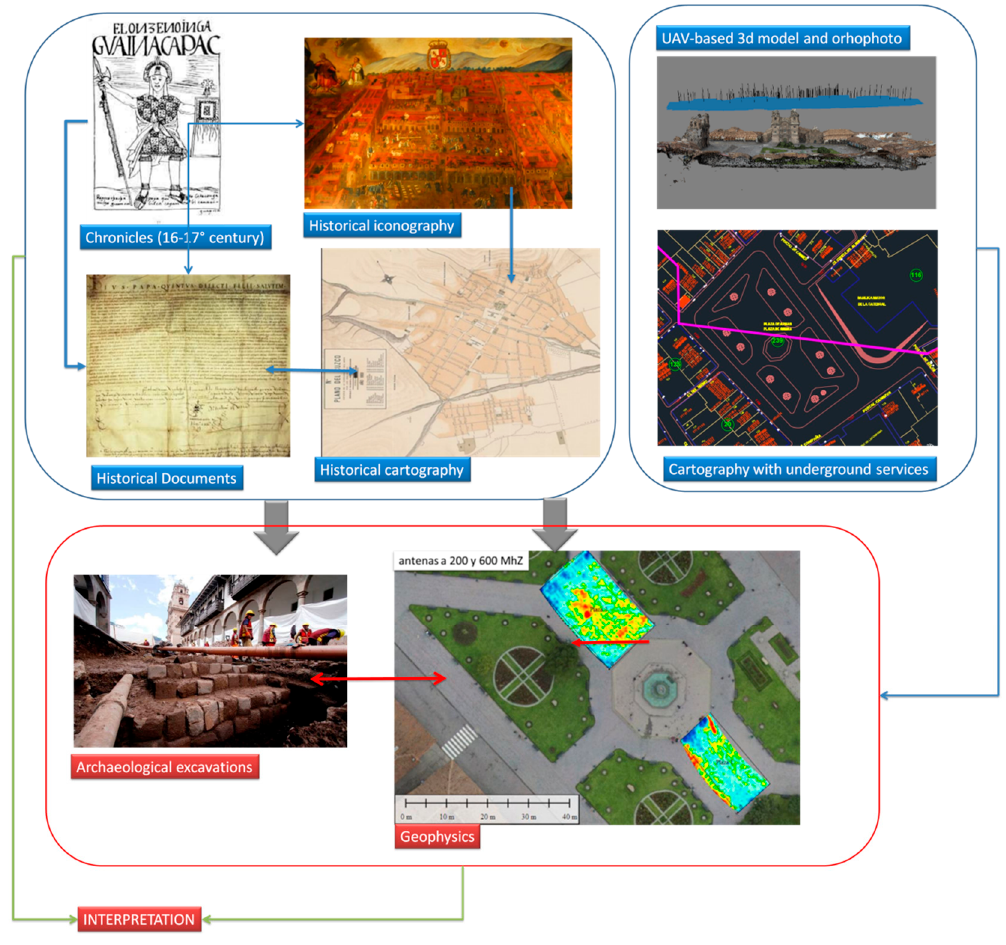
Figure 2. Methodological approach.